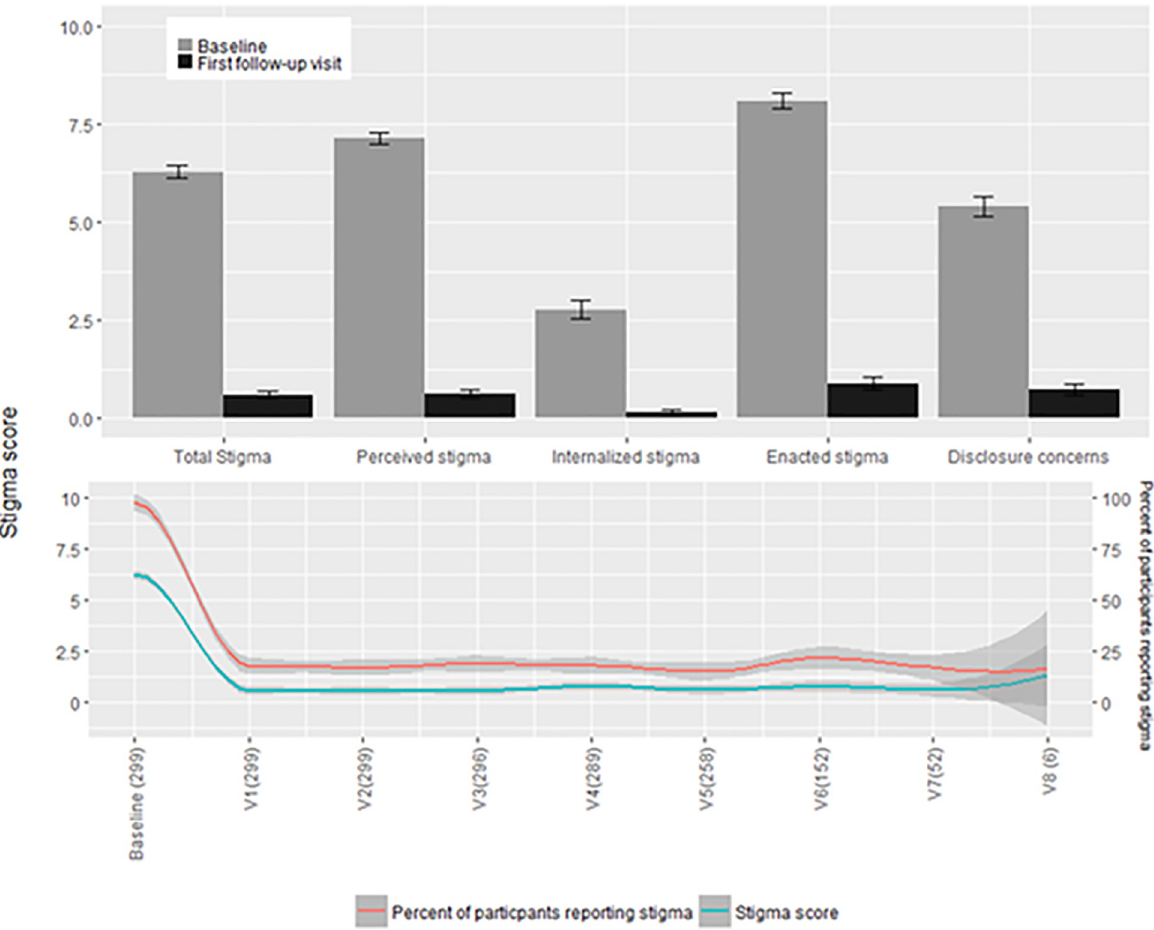
Fig 1. Total and subscale stigma scores at baseline and first follow-up visits. Fig 1: Top-panel: Comparison of mean baseline stigma scores and stigma scores at first follow-up visit for all respondents. Error bars represent standard error. All differences are significant: total stigma [t(505) = 31.88, P < 0.0001], perceived stigma [t(599) = 35.61, P < 0.0001], internalized stigma [t(330) = 10.70, P < 0.0001), enacted stigma [t(563) = 29.65, P < 0.0001], disclosure fears [t(472) = 15.69, P < 0.0001]. Bottom panel: Scatter plots of the proportion with at least one stigma indicating response across visits and the mean stigma scores for all respondents with local regression lines using LOESS method and span = 0.2. X-axis labels are the study visit followed by the number of participants sampled at that visit. Later study enrollees have not yet reached visits 6, 7 and 8. Gray bands represent 95% confidence intervals. All follow-up visits are significantly different from the baseline-visit (F 8,1941 = 282.1, p < 0.0001), and do not significantly differ from each other (F 7, 1643 = 1.145, p = 0.33).